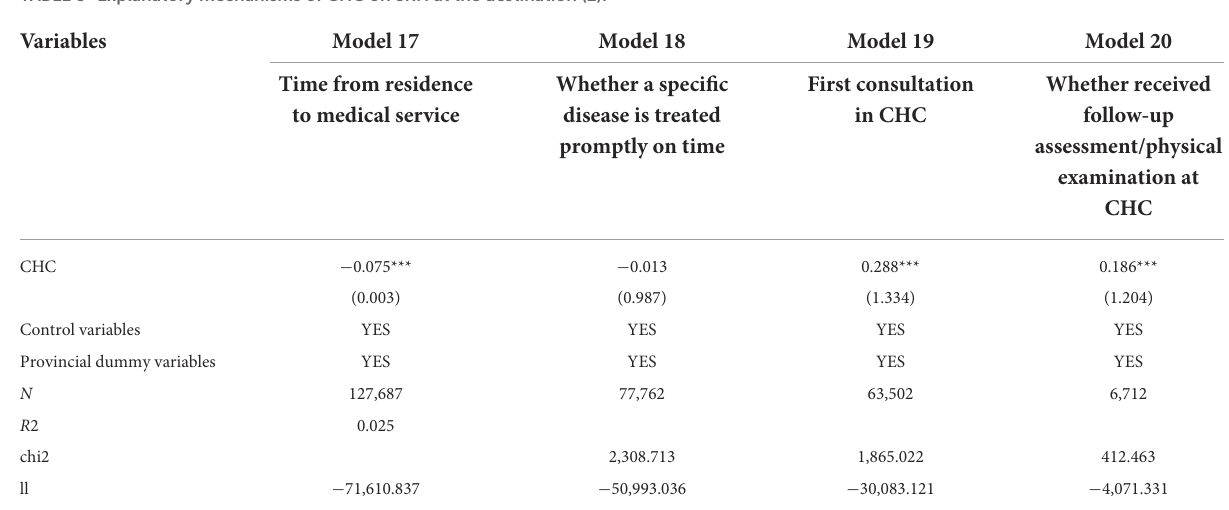
TABLE 8 Explanatory mechanisms of CHC on SRH at the destination (2).